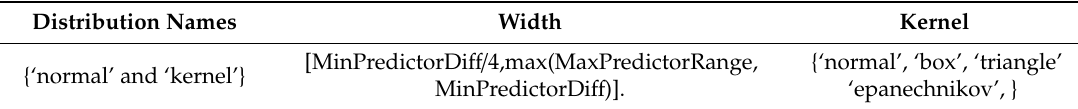
Table A7. Matlab toolbox NB optimization parameter settings.